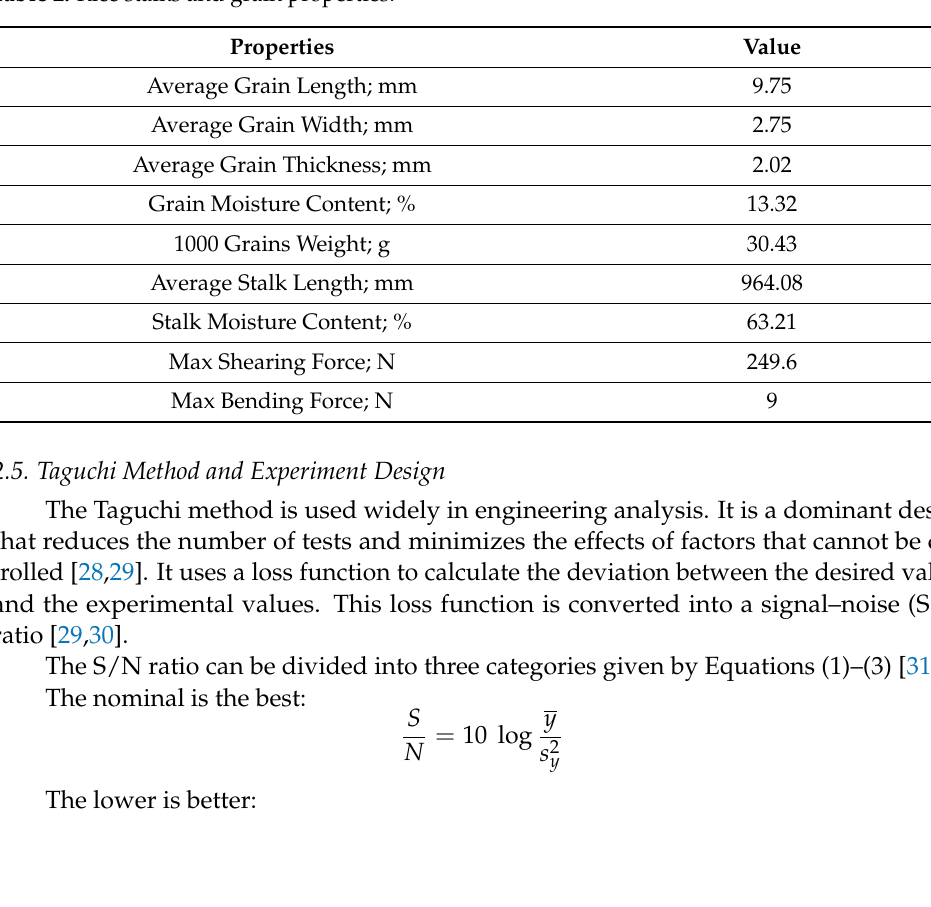
Bending test Shearing test Figure 4. Bending and shearing test. Figure 4. Bending and shearing Table 2. Rice stalks and grain properties.